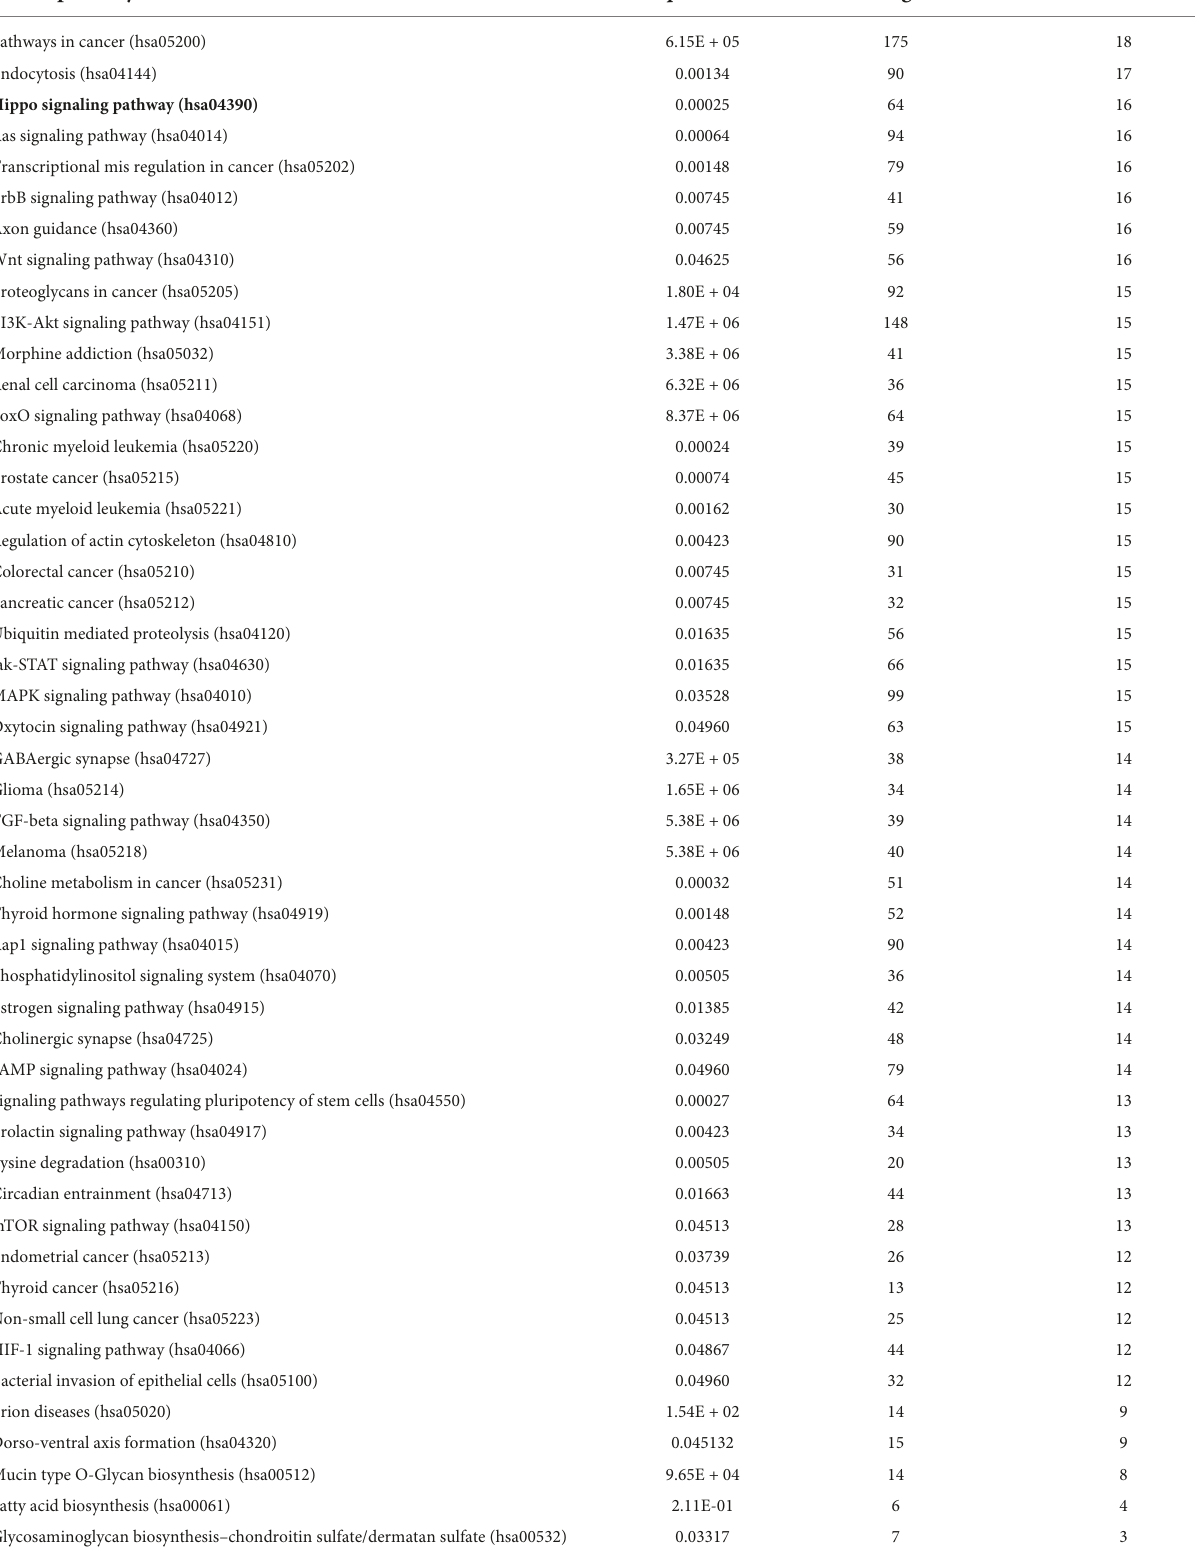
TABLE 5 KEGG pathway 20 downregulated